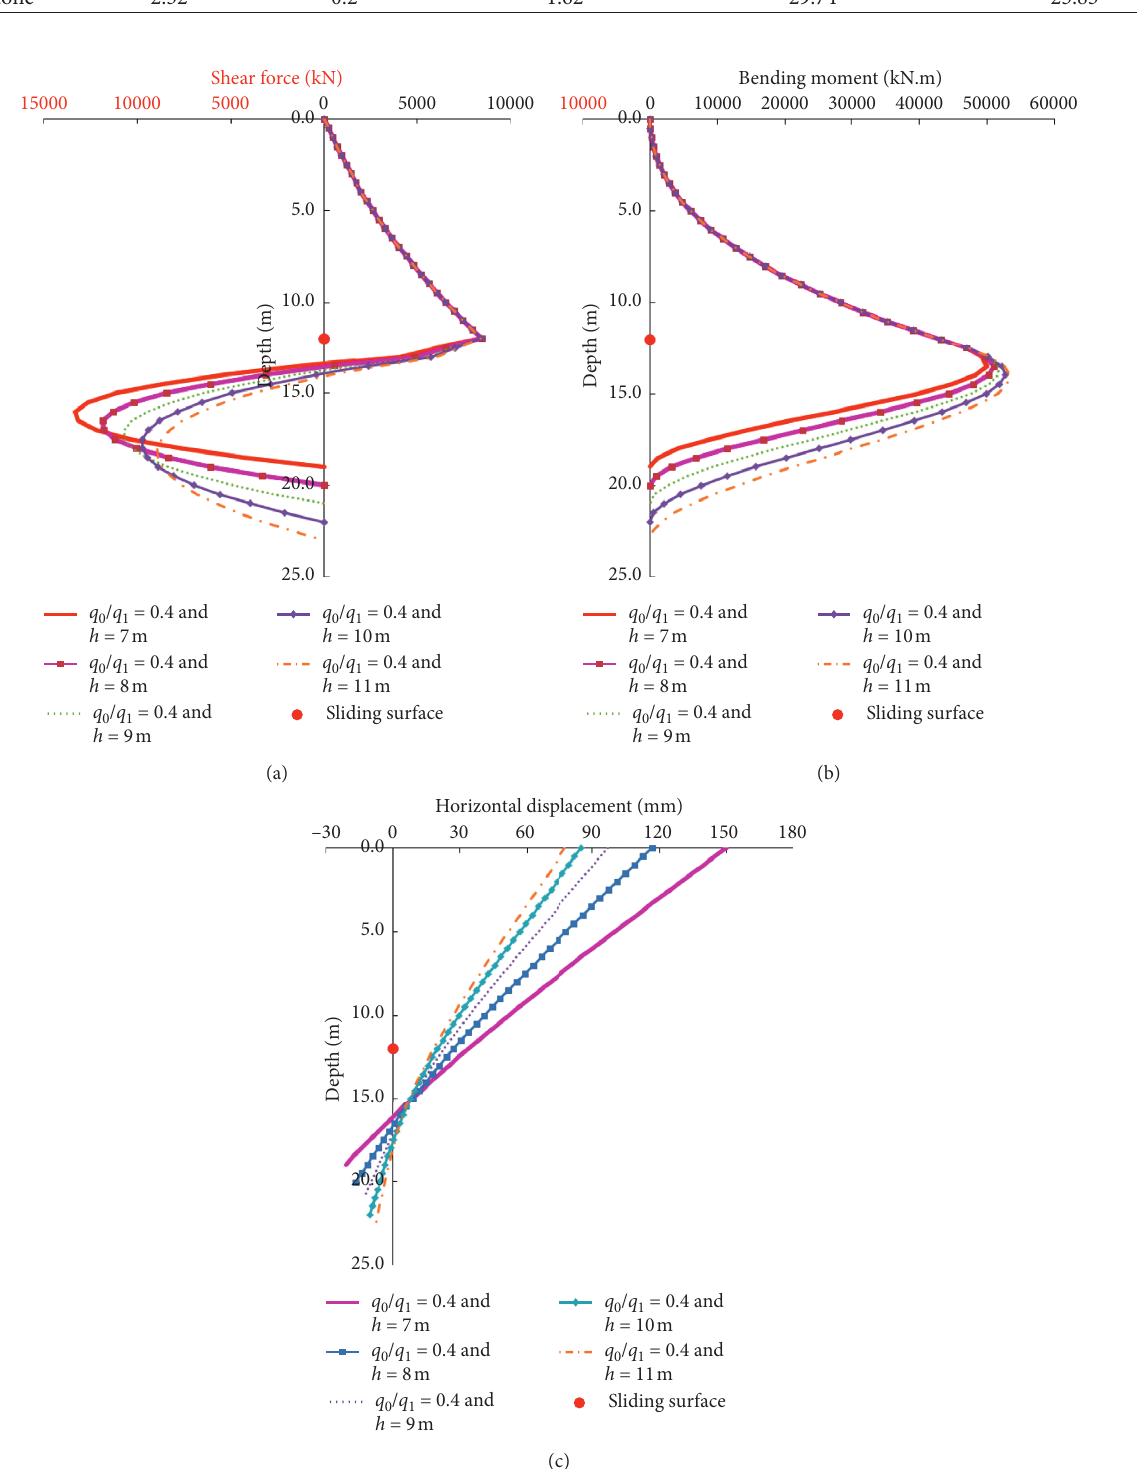
Figure 7: Calculation results of the displacement and internal forces of the pile under different embedded lengths h with q 0/ q force. (b) Bending moment. (c) Horizontal displacement.